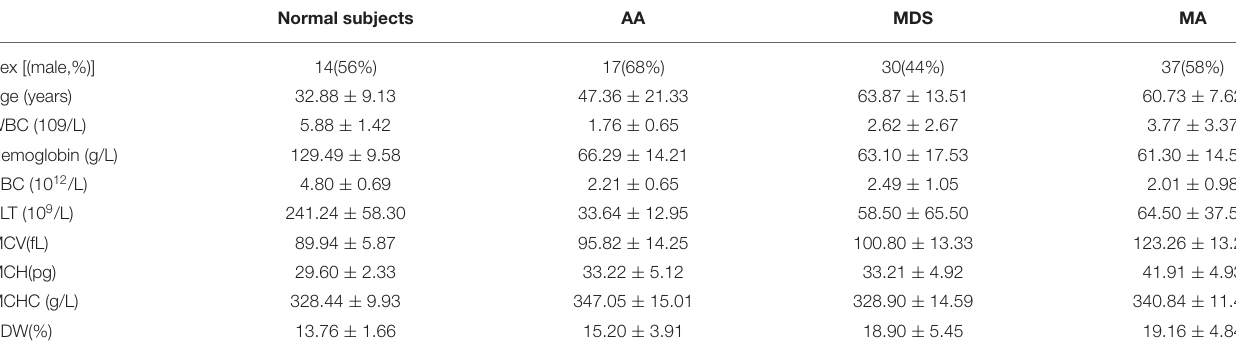
TABLE 1 | The characteristics of normal subjects and patients with AA, MDS, and MA. Normal subjects